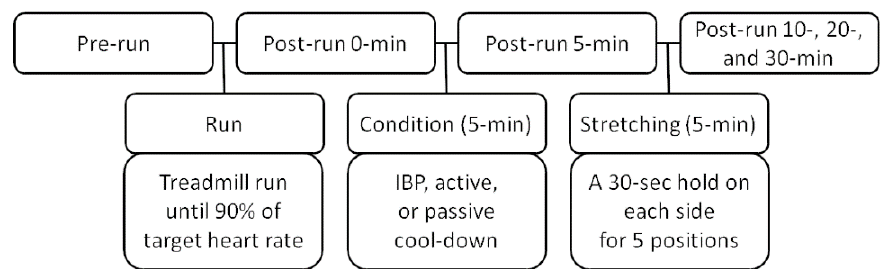
Figure 1. Testing procedures, IBP: inverted body position. Heart rate, energy expenditure, fatigue perception, circumference of lower-extremity, and blood lactate were recorded at each measurement time.